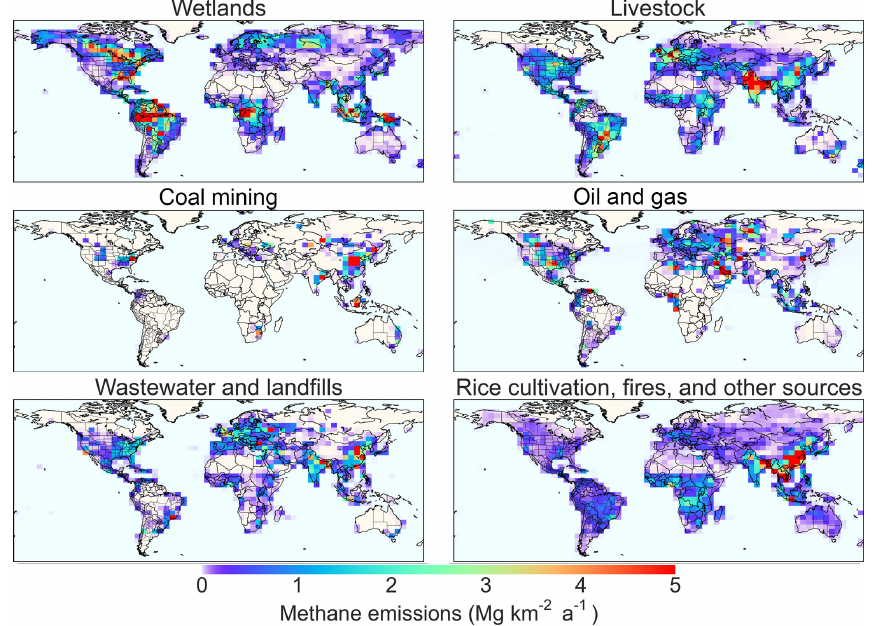
Figure 2. Prior estimates of methane emissions from wetlands, livestock, coal mining, oil and gas, wastewater and landfills, and other sources. Values are 2010–2015 averages and are shown on the 4 ◦ × 5 ◦ GEOS-Chem grid used for the inversion. Global totals for each source type are given in Table